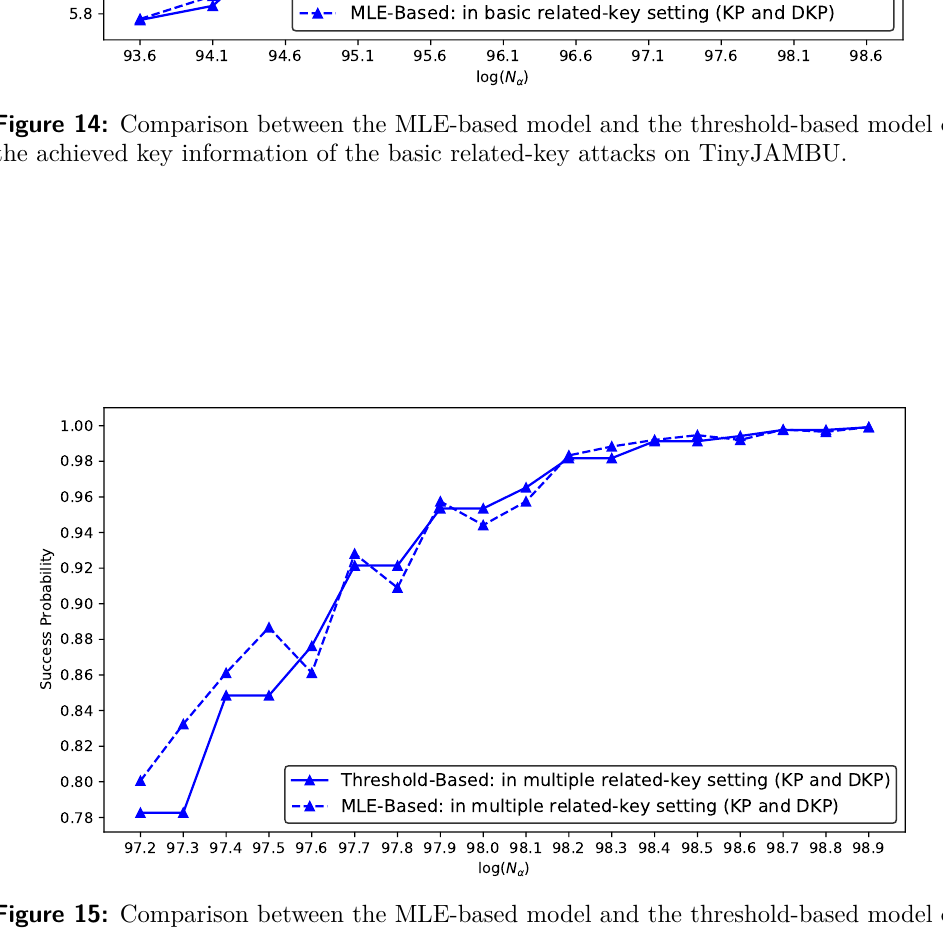
Figure 15: Comparison between the MLE-based model and the threshold-based model of the success probabilities of multiple related-key attacks on